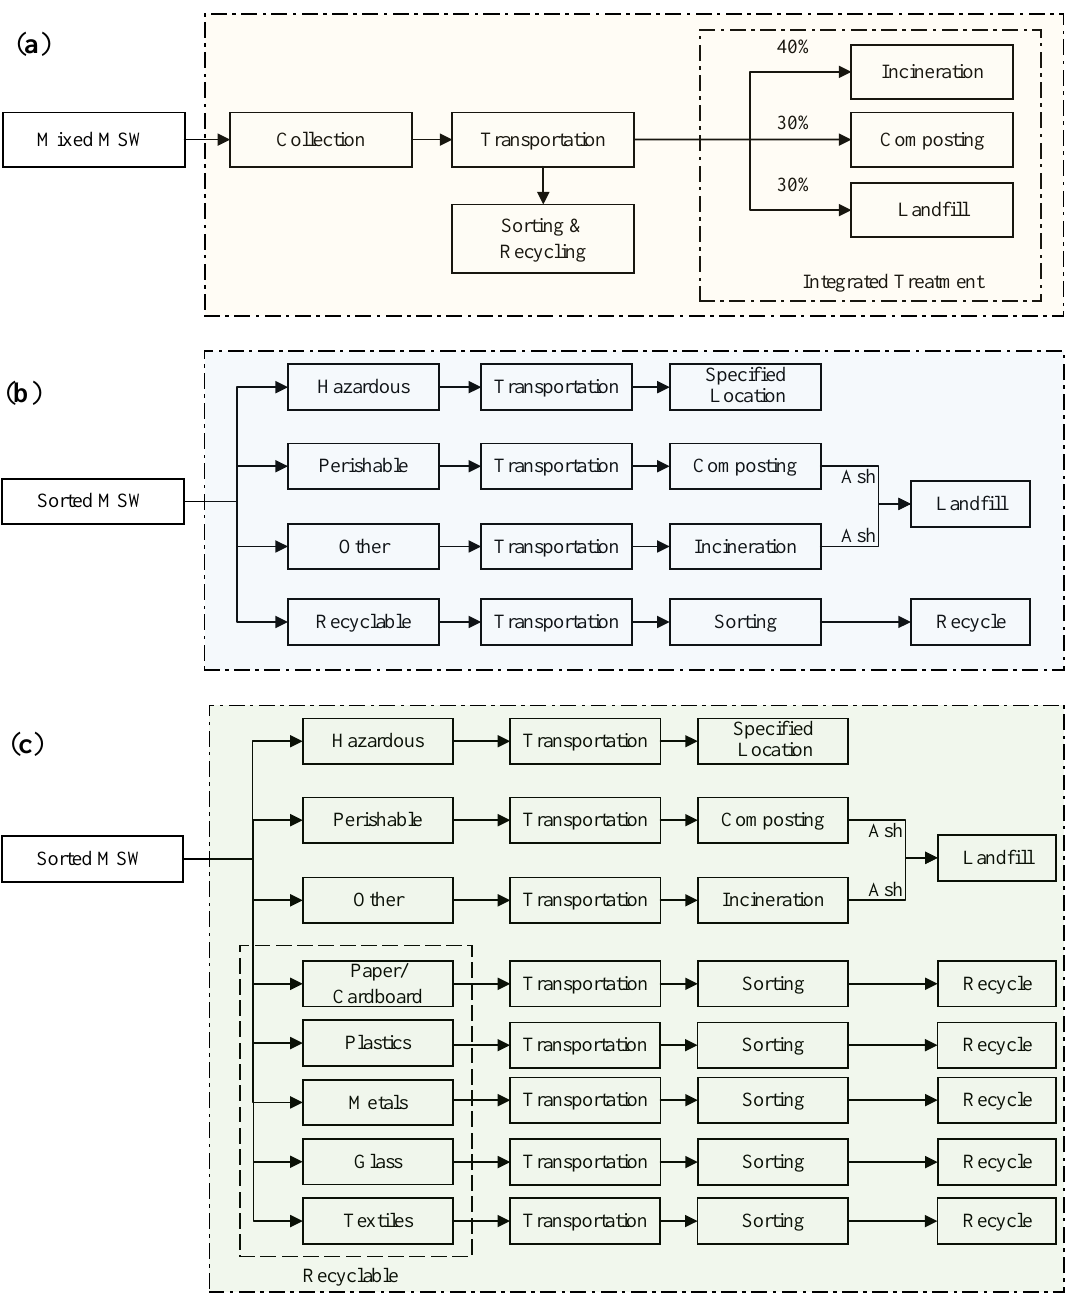
Figure 1. Schematic flowcharts of municipal solid waste (MSW) management systems based on proposed scenarios in China under study. ( a ) Scenario 1 (S-1); ( b ) Scenario 2 (S-2); ( c ) Scenario 3 (S-3)